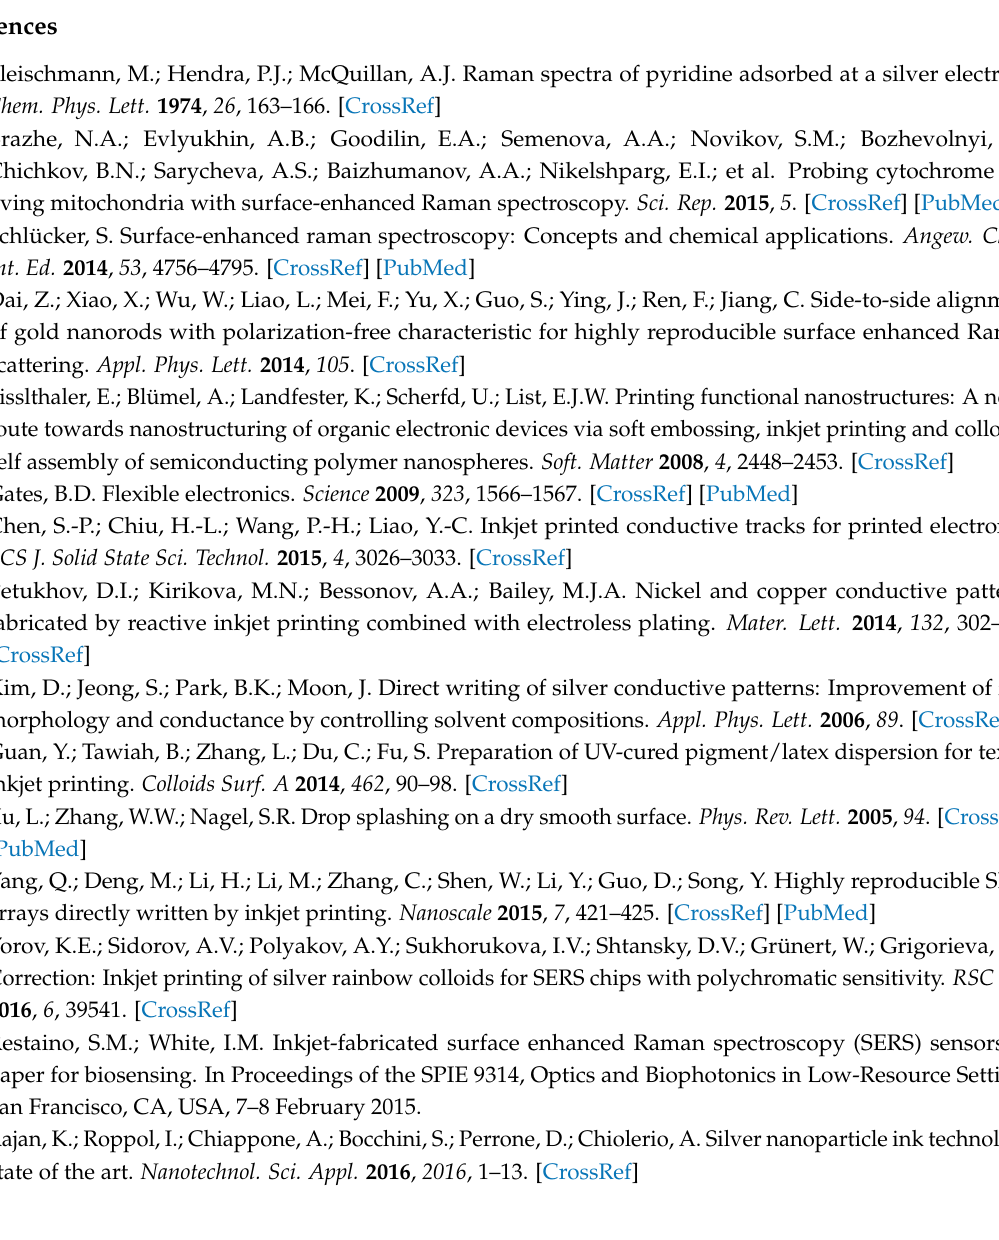
Figure S1: The hypothetic scheme for polycolor SERS platform production using photo-reactive silver complex inks; Table S1: Characteristics of silver citrate complex in water–polyol (H 2 O–EG) media of different volumetric ratios. Some details on Ink quality characterization are also